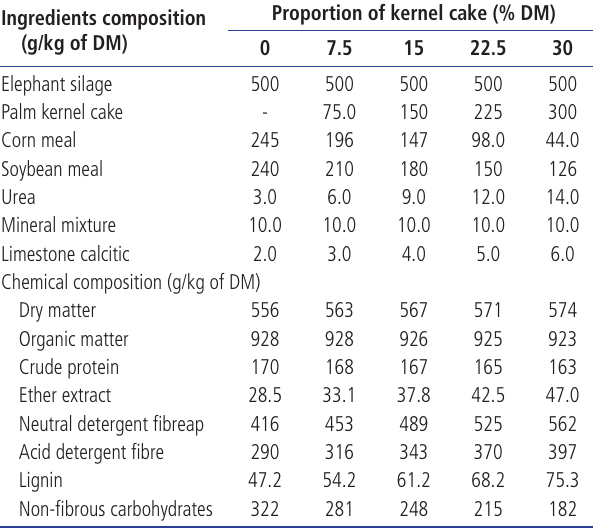
Table 1. Ingredients and chemical composition of the experimental diets Ingredients composition (g/kg of